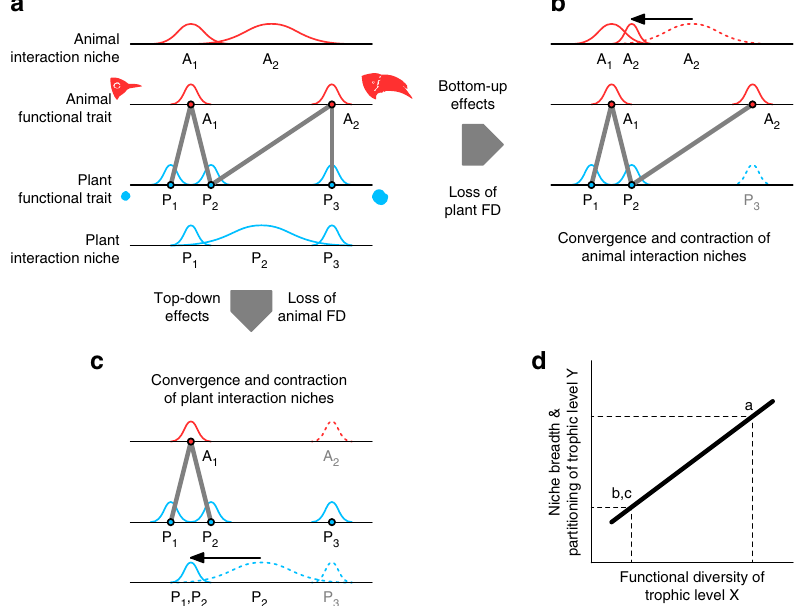
Fig. 1 Potential bottom-up and top-down effects of plant and animal functional diversity on the assembly of mutualistic networks. a Example of a mutualistic bird – fruit network, in which plants and animals are ordered along two corresponding size-matching trait axes according to bill and fruit size, respectively. The grey lines represent bird – fruit interactions, which are constrained by trait matching so that the small-billed bird can only consume small fruits, whereas the large-billed bird can also consume large fruits. Trait matching determines the realised interaction niches of plants and animals (represented on the trait axis of the other trophic level). b Removal of plant species P 3 causes a loss of plant functional diversity and a contraction and convergence of the birds ’ interaction niches corresponding to a reduction in niche breadth (diversity of a species ’ interaction partners) and niche partitioning (complementary specialisation of several species on exclusive interaction partners; red histograms A 1 and A 2 at the top). c Likewise, removal of bird species A 2 causes a loss of animal functional diversity and a contraction and convergence of plants ’ interaction niches (blue histograms P 1 and P 2 at the bottom). d Consequently, a loss of functional diversity in one trophic level should cause a reciprocal reduction in niche breadth and partitioning in the other trophic level. Note that the convergence of interaction niches also implies that a reduction of functional diversity in one trophic level may cause increased competition for mutualistic partners in the other trophic level (e.g., between A 1 and A 2 in b or between P 1 and P 2 in c